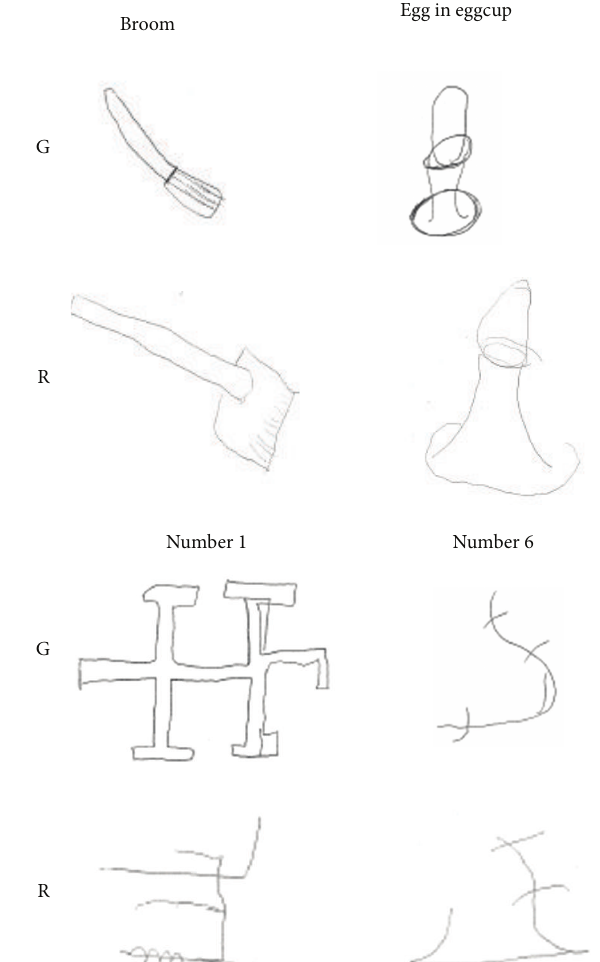
Figure 7: Examples of immediate visual memory for objects